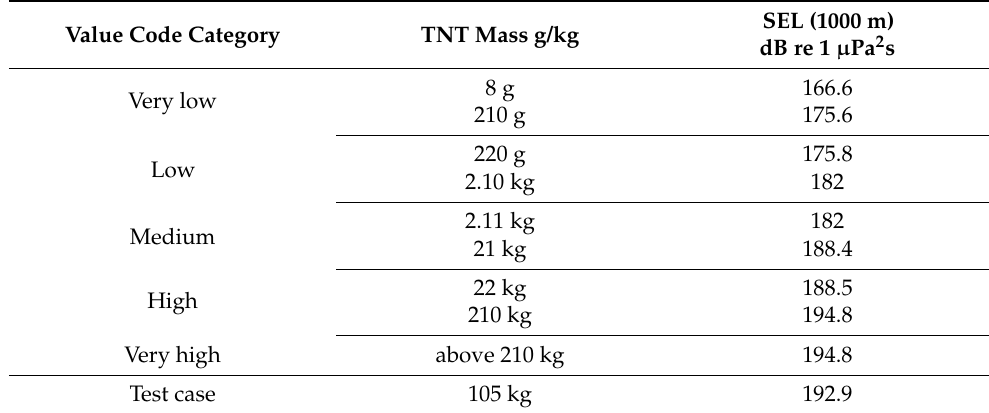
Table 7. Source description according to Formula (2) obtained for a distance of 1000 m to the source for the classification of explosion